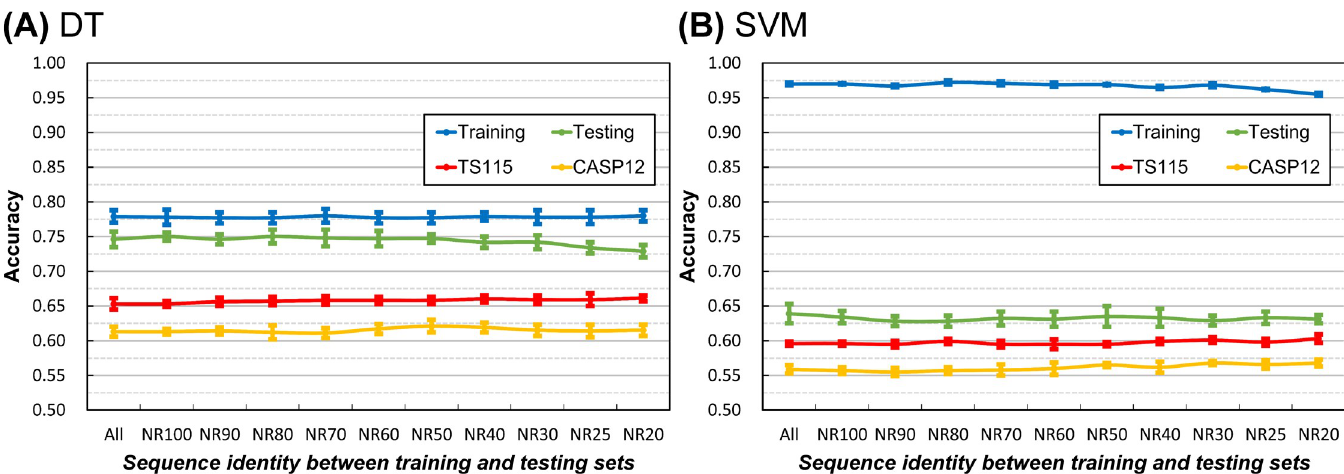
Fig 8. Effects of the homology between training and testing query datasets on SSP accuracy obtained with decision tree or support vector machine. (A) Results of the decision tree. (B) Results of the support vector machine. This test’s procedure was the same as the experiment of Fig 1, but the inner-dataset sequence identity cutoff of the training and testing query sets was fixed at 40%, and the machine learning algorithms were the decision tree and SVM. Even when an algorithm prone to overfitting was applied, the inter-dataset homology between the training and testing query sets had little influence on SSP accuracy, consistent with ANN results. Although the influence was minor, the homology reduction between these query sets still contributed to the decrease of overfitting. At very low sequence identity, either the gap between the accuracy of training and testing reduced or the accuracy of independent tests increased slightly.